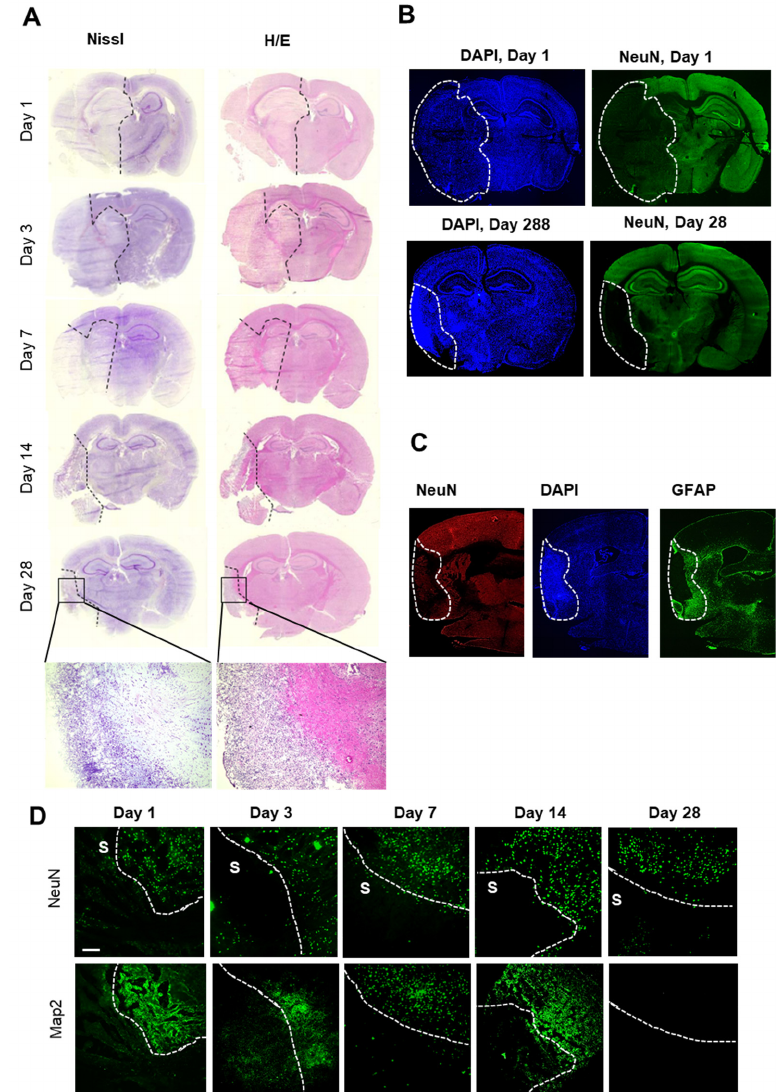
Figure 2. Histochemical and immunohistochemical analyses of the stroke area. ( A ) Nissl- and H/E- staining of brains at the indicated times after stroke induction. The black dashed lines depict regions with severe cell loss. ( B ) Immunohistochemical staining for nuclei (DAPI) and neurons (NeuN). The white lines depict areas with severe neuronal loss. ( C ) Immunohistochemical staining for nuclei (DAPI), astrocytes (GFAP) and neurons (NeuN). The white dotted lines depict the area with severe neuronal loss (ischemic core). ( D ) Immunohistochemical staining of areas at the border between stroke (S) and unaffected tissue for MAP2 and NeuN. The white dotted lines depict the border be- tween stroke and unaffected tissue. The white bar represents 100 µm.